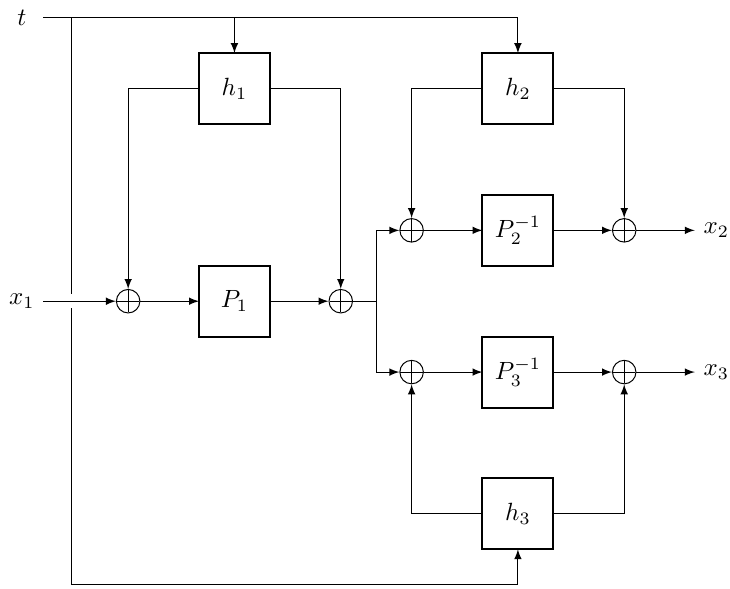
Figure 1: Tweakable Even-Mansour forkcipher of (1,1)-round, based on public permutations P 1 , P 2 , P 3 and hash functions h 1 , h 2 , h 3